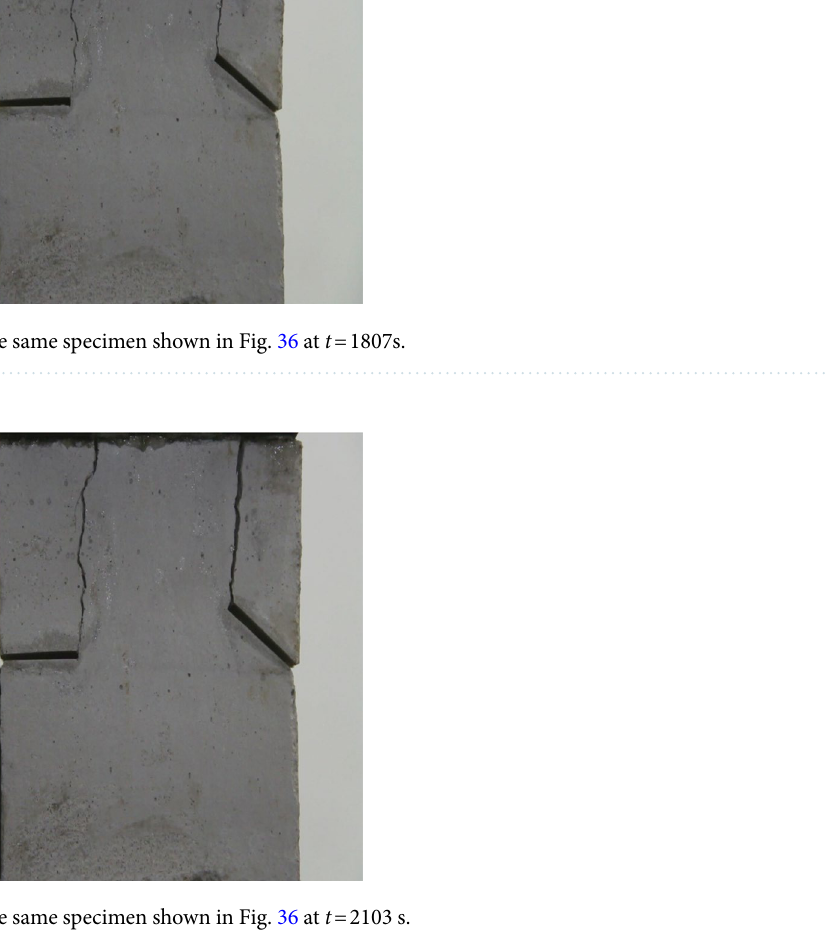
Figure 39. The same specimen shown in Fig. 36 at t = 2103 s.